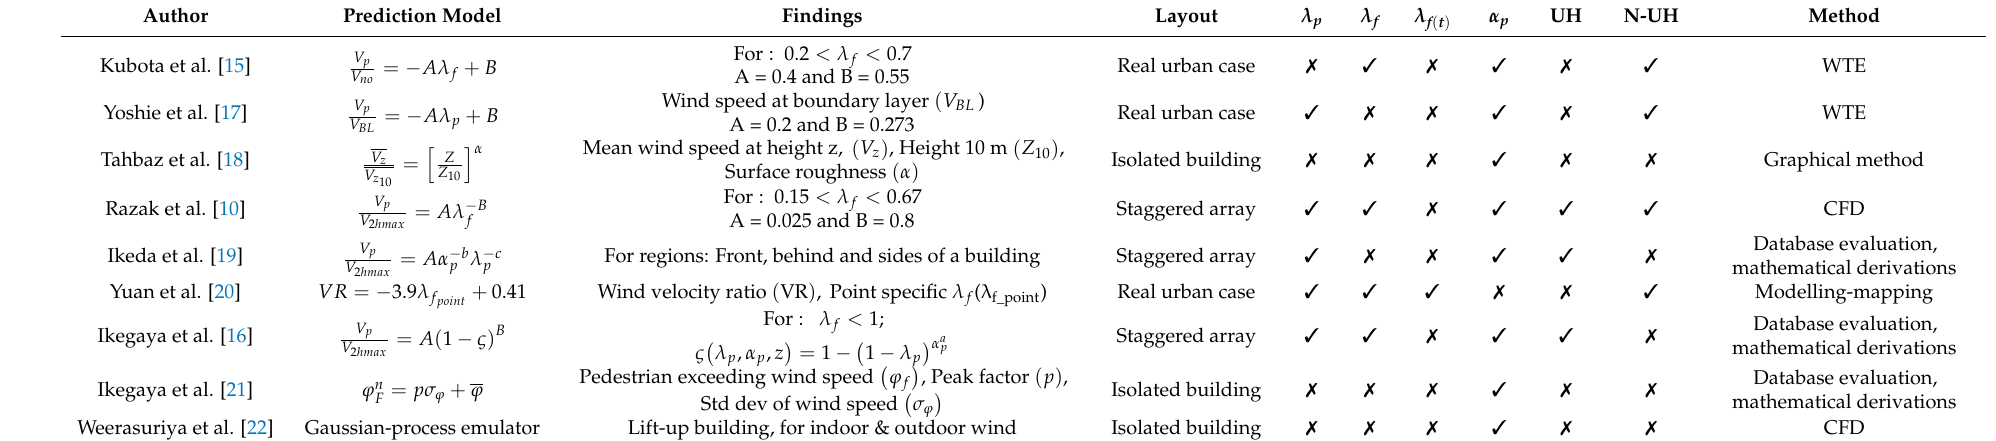
Table 1. Overview of studies on the prediction model of mean velocity ratio at pedestrian